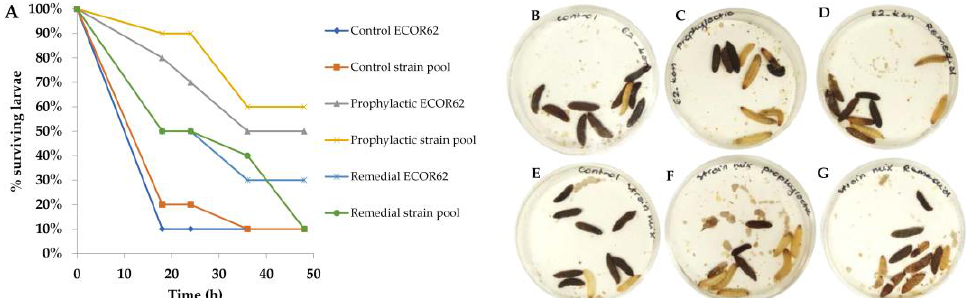
Figure 5. Evaluation of prophylactic and remedial phage therapy treatments of larvae infected with a single strain (ECOR62) or a mixture of five ECOR strains ( n = 10). The number of surviving larvae after 48 h incubation at 37 ◦ C was recorded and plotted ( A ). Controls in which the single strain ECOR62 alone ( B ) or strain combinations ( E ) were included. Prophylactic ( C , F ) and remedial ( D , G ) treatments of the single or combined strain pool, respectively, at an MOI of 100, were evaluated for their therapeutic potential. Prophylactic treatment was observed to be most effective in both single and mixed-strain assays. The number of larvae displaying melanization after the incubation period was recorded and plotted in the graph. Similar effects of the individual strain and strain pool were observed, while the larvae group treated with phages prophylactically displayed higher survivability and reduced melanization compared to the control and remedially treated cohorts. Panels ( B – G ) represent the results at the 16 h time-point.